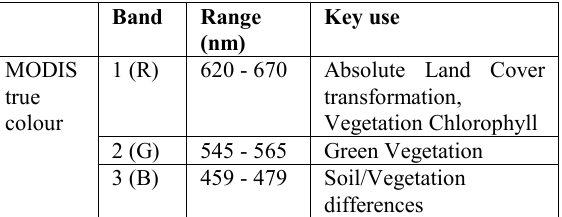
Table 3. The usages of MODIS true colour